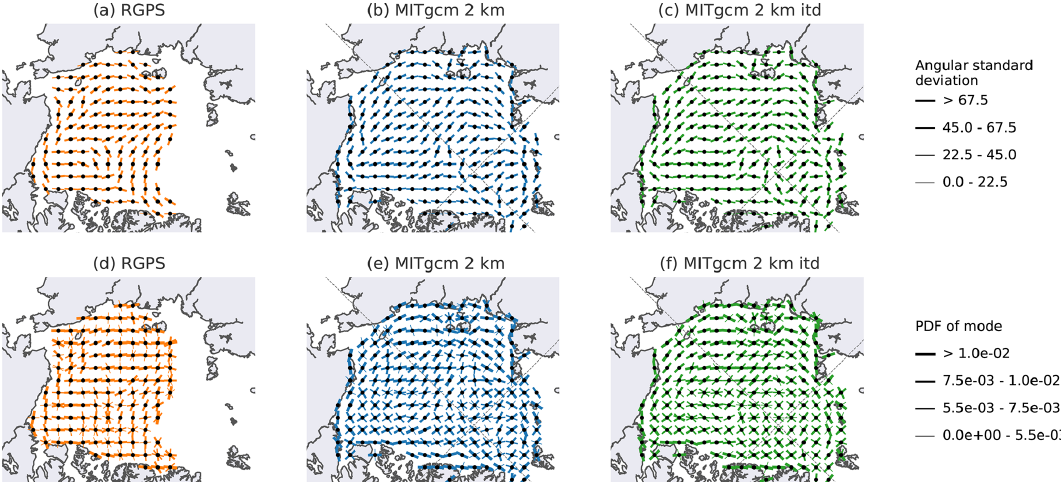
Figure 6. (a, b, c) Mean orientation of LKFs for RGPS and two model simulations for the winters between 1996 and 2008. We follow the definition of mean and standard deviations for circular data from Bröhan and Kaleschke (2014) for lead orientations. The line width indicates the standard deviation of the distribution within the cell. Orientation distributions that are statistically significantly different from a random distribution are marked by a black dot. Only cells that contain more than 500 LKFs are shown. (d, e, f) Modal orientation of LKFs for RGPS and two model simulations. The three largest modes of the distribution of orientation are plotted for cells that include more than 500 LKFs. The probability (PDF) of each mode is shown by the line length, where a PDF value of 5 . 5 × 10 − 3 corresponds to the mean PDF value of a random distribution. In panels (b) , (c) , (e) , and (f) the 0, 90, 180, and − 90 ◦ meridians are shown as dashed grey lines. The numerical grid lines of both simulations are parallel to these